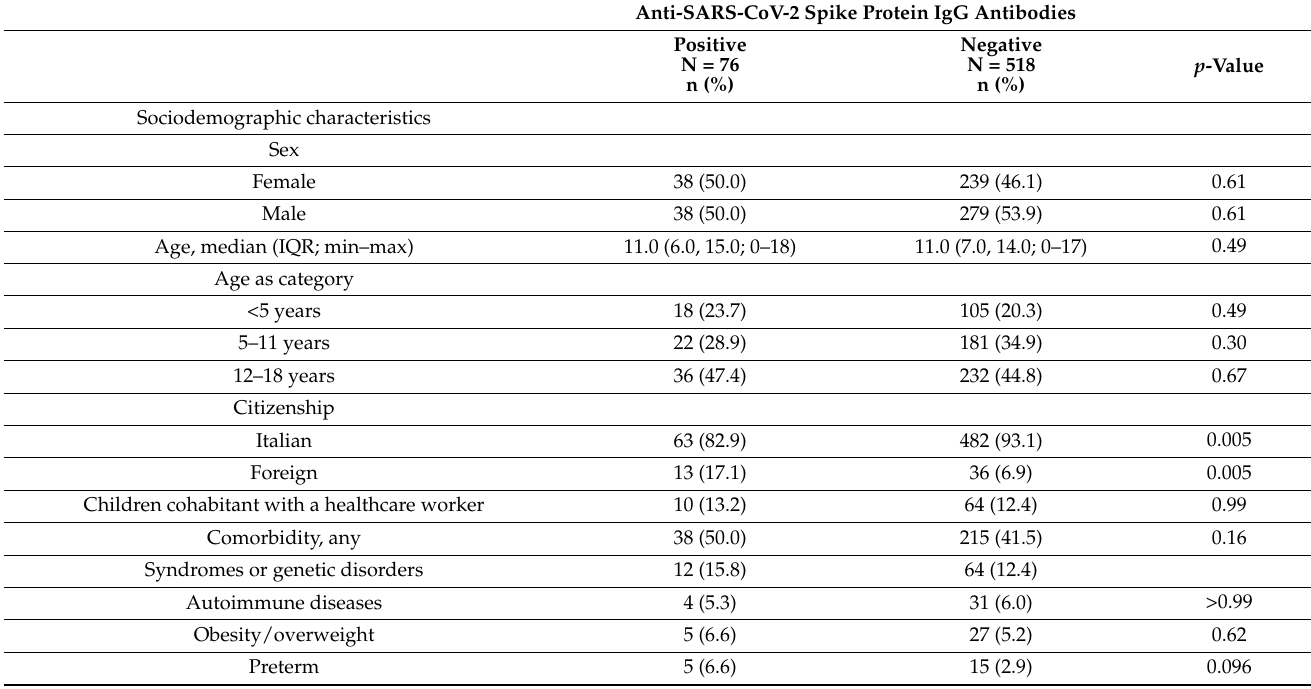
Table 3. Characteristics of children presenting anti-SARS-CoV-2 Spike protein IgG antibodies vs. children not presenting anti-SARS-CoV-2 Spike protein IgG